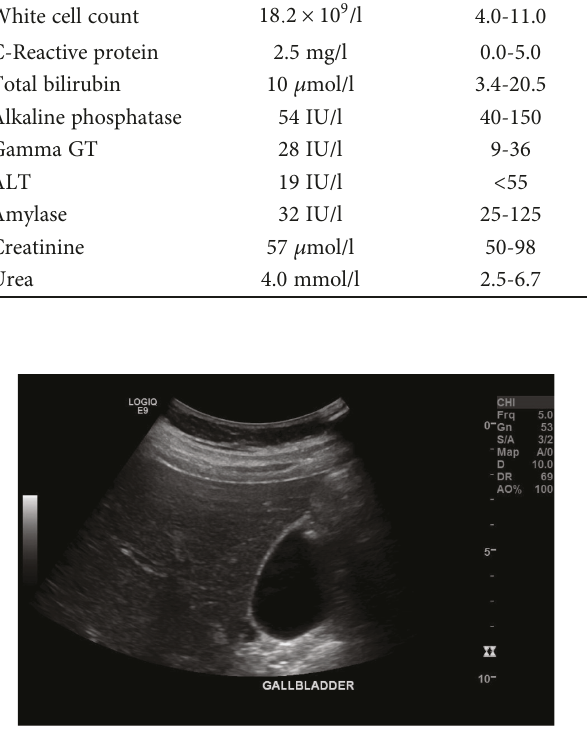
Figure 1: US of the abdomen. Gallbladder with no sonographic evidence of cholecystitis or cholelithiasis.